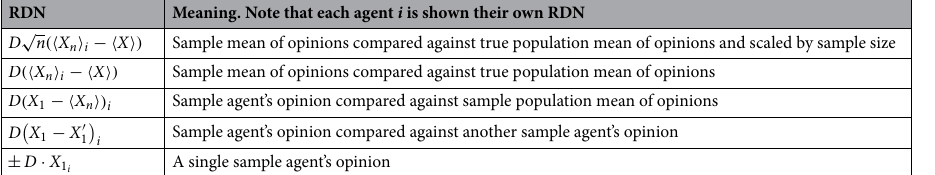
RDN Meaning. Note that each agent i is shown their own RDN D √ n ( X n X ) Sample mean of opinions compared against true population mean of opinions and scaled by sample size � � i − � � D ( X n X ) Sample mean of opinions compared against true population mean of opinions � � i − � � D ( X 1 X n ) − � �